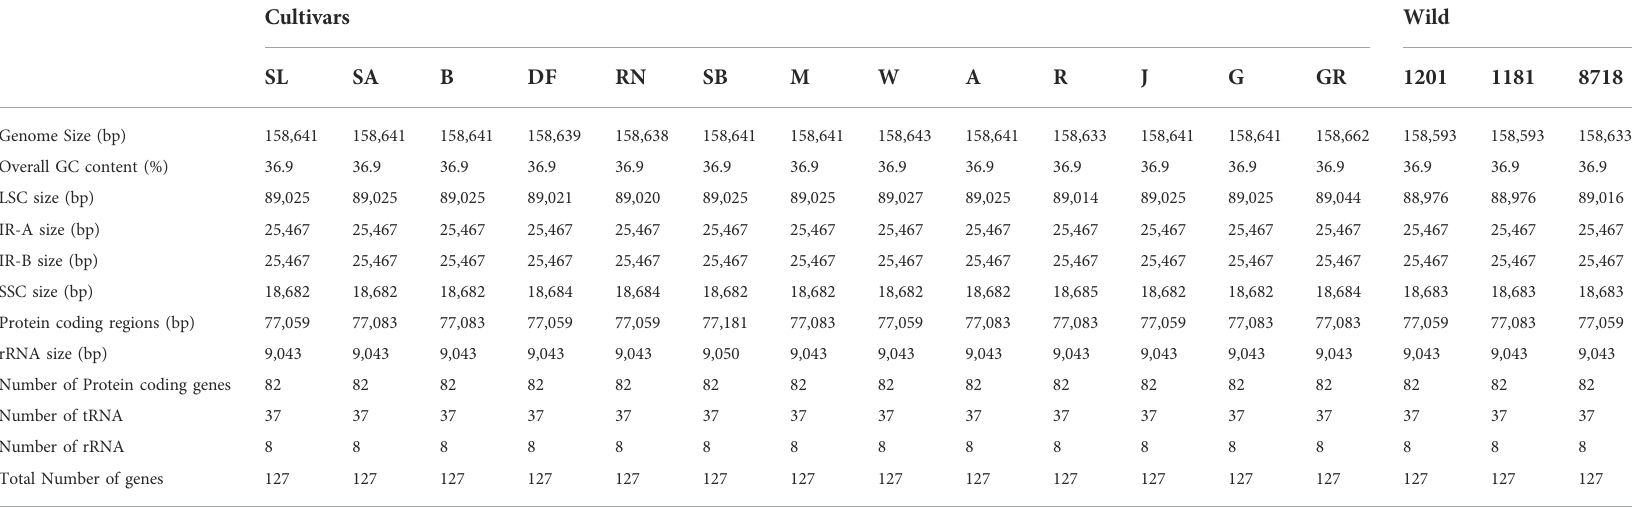
TABLE 2 Summary of complete chloroplast genomes of 16 pomegranate genotypes. Parameters